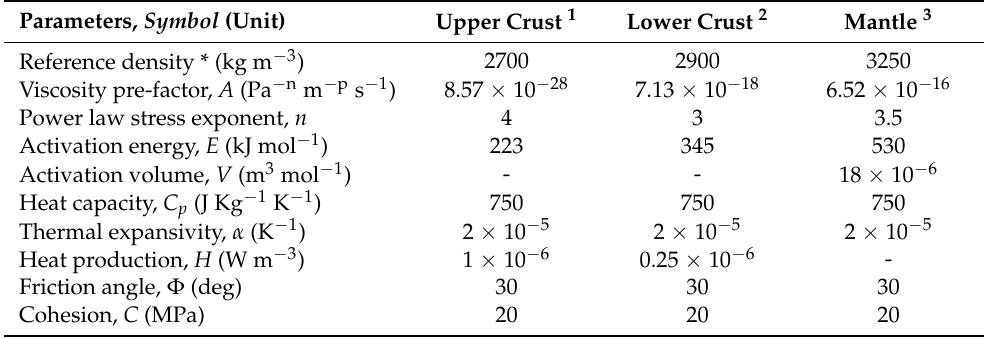
Table 1. Physical properties of the different lithologies [40]. 1 Wet quartzite [47], 2 wet anorthite